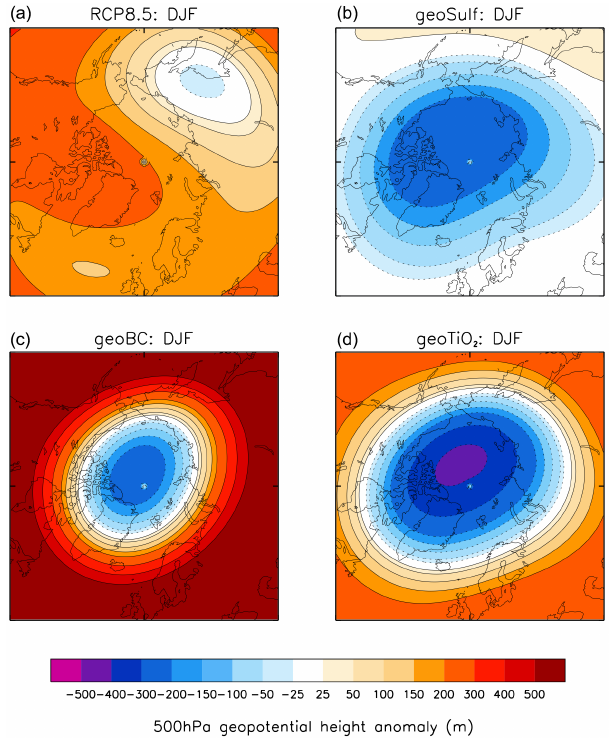
Figure 11. DJF 50hPa geopotential height